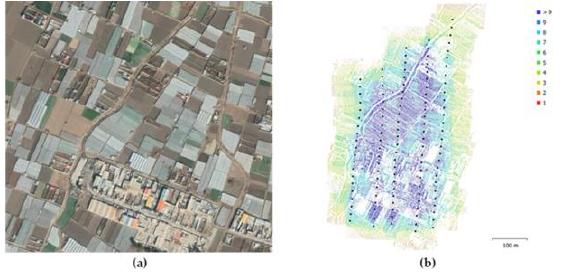
Figure 2. Google Earth imagery of the study area. (a)